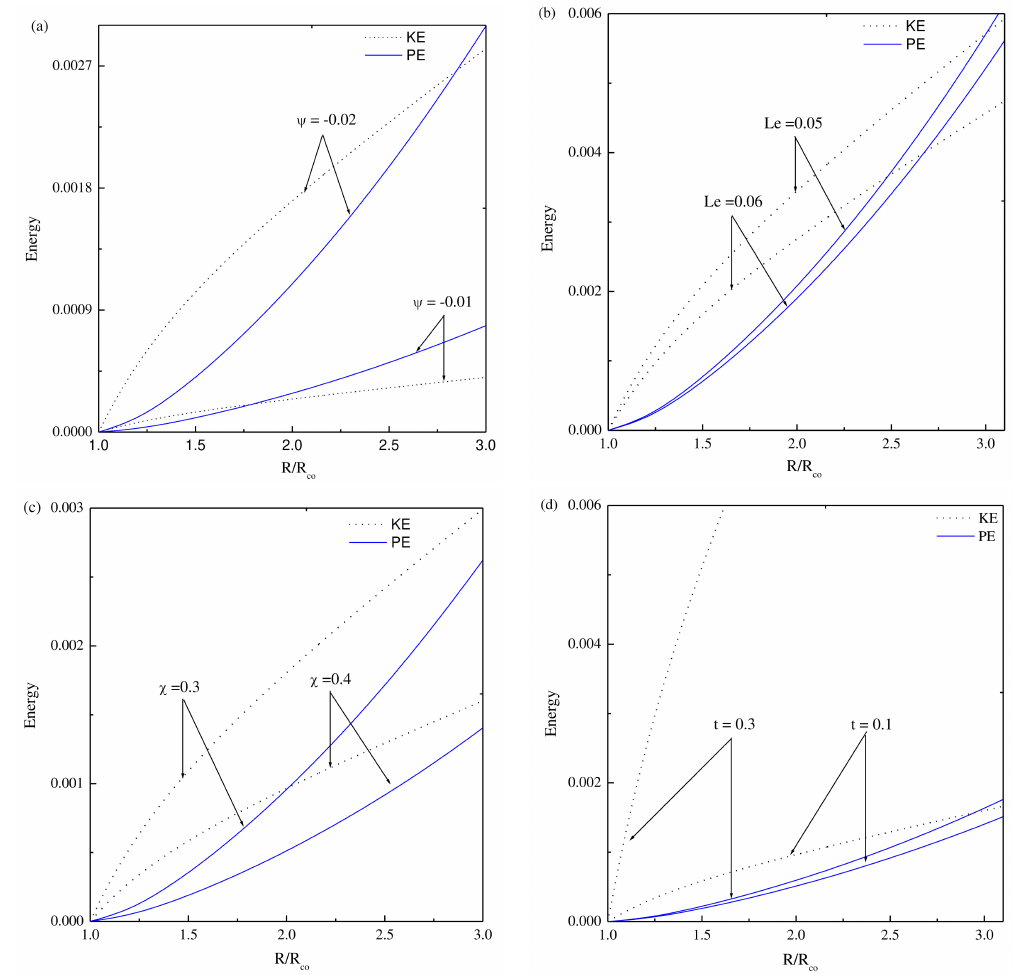
Figure 7. Energy (Kinetic energy (KE) and potential energy (PE)) with respect to R / R co . ( a ) Le = 0.04, χ = 0.2, t = 0.1 and ψ = − 0.02, − 0.01. ( b ) ψ = − 0.03, χ = 0.2, t = 0.1 and Le = 0.05,0.06, ( c ) Le = 0.04, ψ = − 0.03, t = 0.1 and χ = 0.3,0.4, ( d ) Le = 0.04, ψ = − 0.03, χ = 0.2, and t =